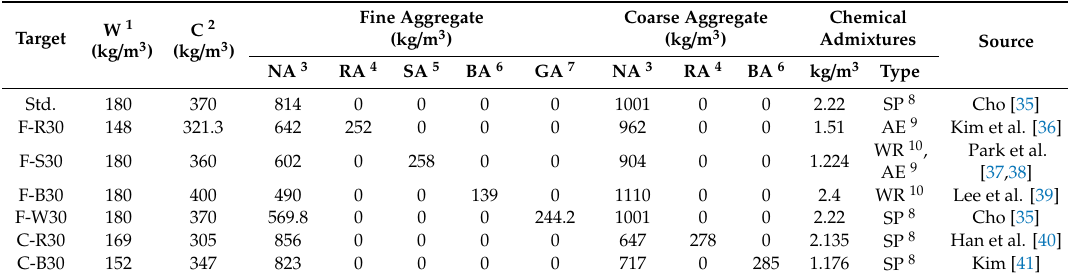
Table 2. Concrete Mixture Proportions of Evaluation Targets.